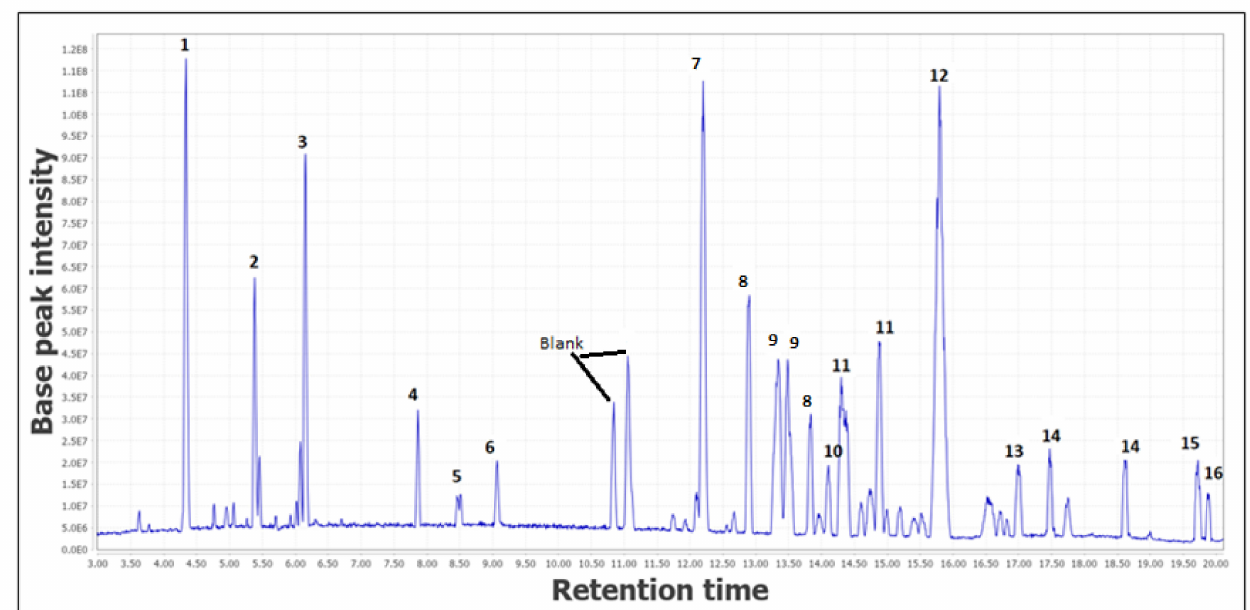
Figure 2. Total ion chromatogram (TIC) in negative ion mode of the leaf extract. The number above each peak represents the peak numbers, corresponding to the peak numbers in Table